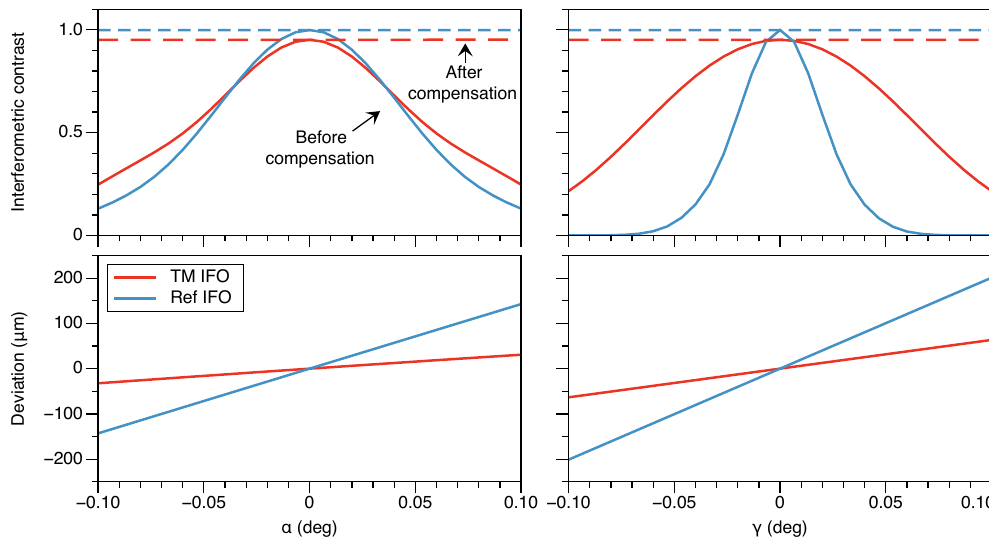
Figure 5. Sensitivity to manufacturing imperfections affecting the relative alignment between optical surfaces, as parameterized by the α (left) and γ (right) angles. The top plots show the interferometric contrast as a function of the deviation from the nominal geometry for both interferometers with and without compensation by altering the alignment of the input beam direction. The input beam direction is tuned by translating the fiber injector by up to 1mm, and rotating it by up to 0.5degree. The bottom plots show the deviation from the nominal optical pathlength difference between the arms in both interferometers due to the required compensation.